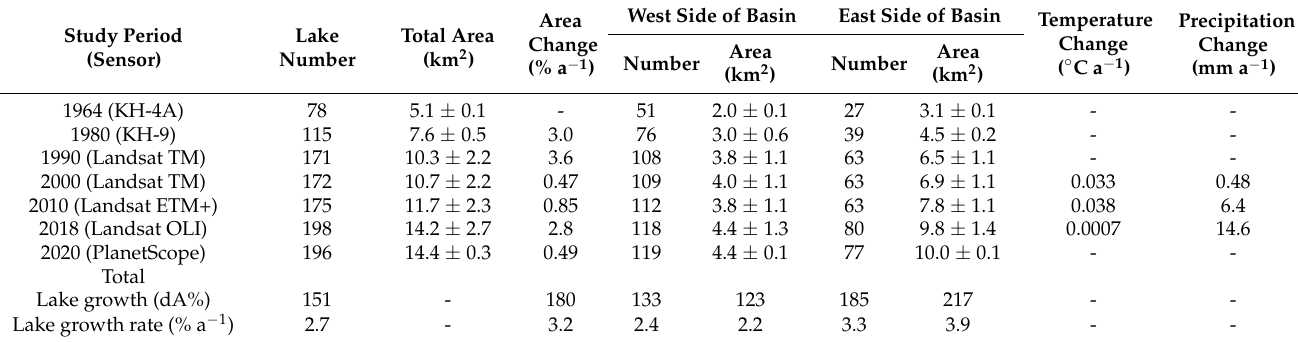
Lake growth (dA%) Note: Temperature and precipitation changes were obtained by calculating the difference between ten-year